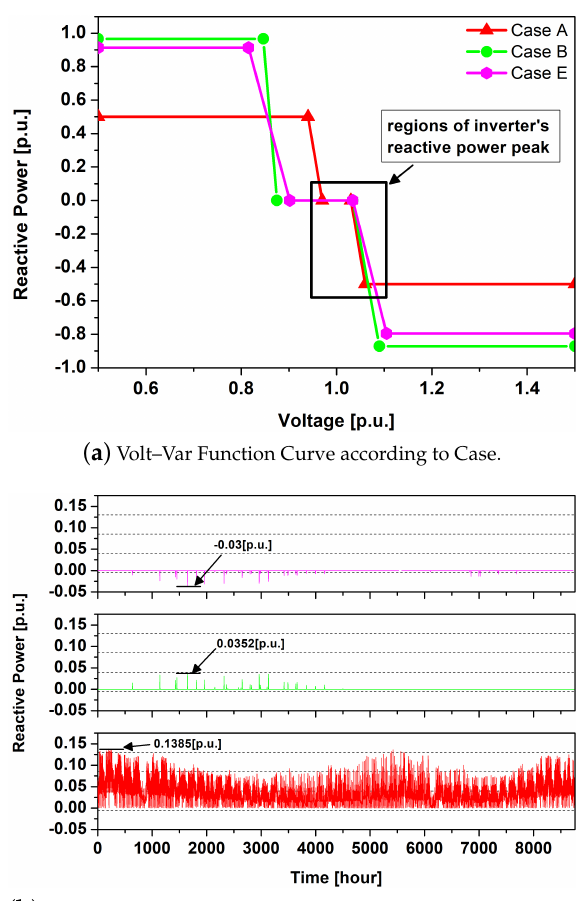
Figure 9. Case Comparison to verify the Improvement Effect on Limiting Reactive Power